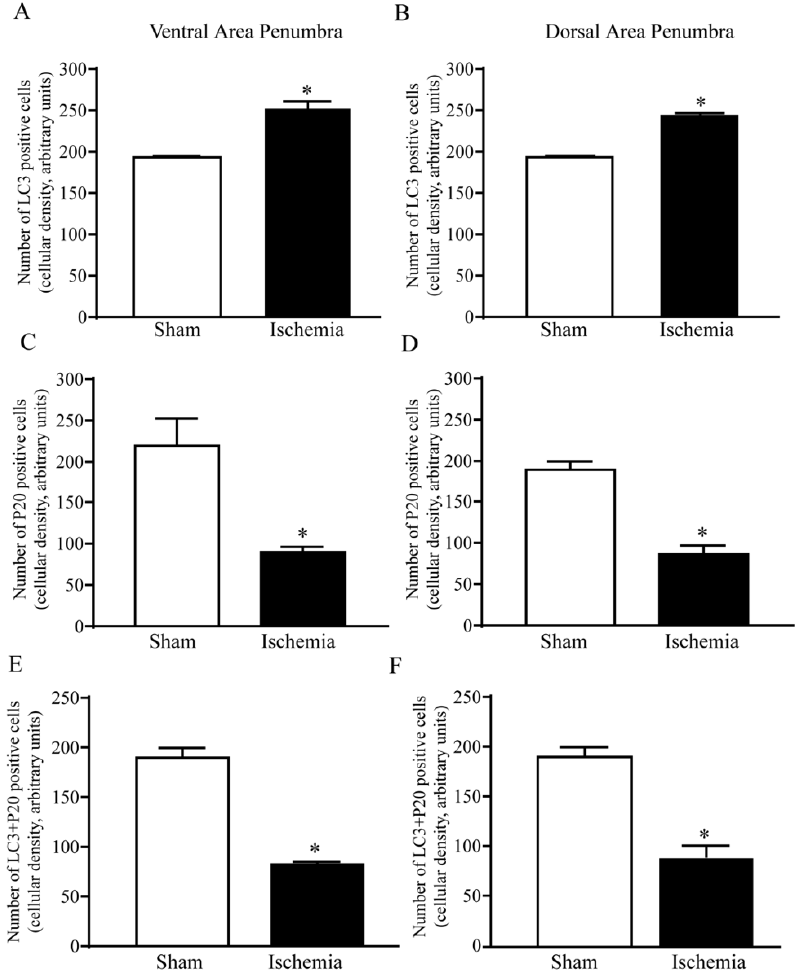
Figure 7. Quantitative analysis of immunofluorescence. Graphs report cellular density in the ventral and dorsal area penumbra (Ischemia) compared with homologous regions from sham-operated controls (Sham). Graphs report the mean ± S.E.M. of LC3-positive neurons ( A , B ), P20S-positive neurons ( C , D ) and co-localization of LC3 + P20S ( E , F ). * p ≤ 0.05 compared with controls (Sham). ( A ) df = 5, t = 4.660, p = 0.0055; ( B ) df = 5, t = 10.88, p = 0.0001; ( C ) df = 5, t = 5.586, p = 0.0025; ( D ) df = 5, t = 5.204, p = 0.0035; ( E ) df = 5, t = 12.12, p < 0.0001; ( F ) df = 5, t = 6.478, p = 0.0013.